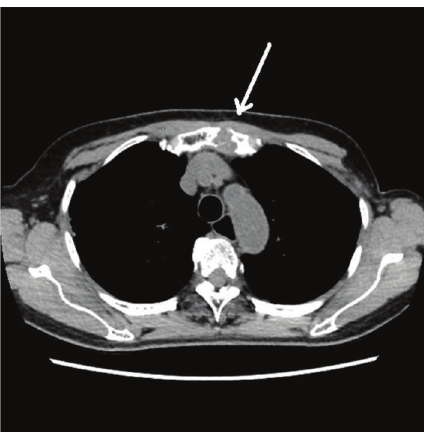
Figure 1: Computed tomography scans of the mass. The arrow indicates the sternal metastasis.